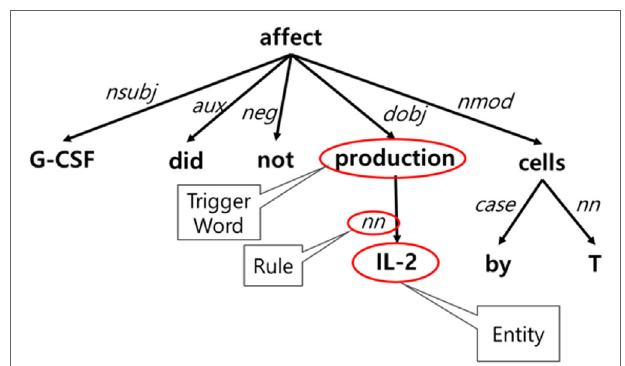
FigUre 6 | An example of rule